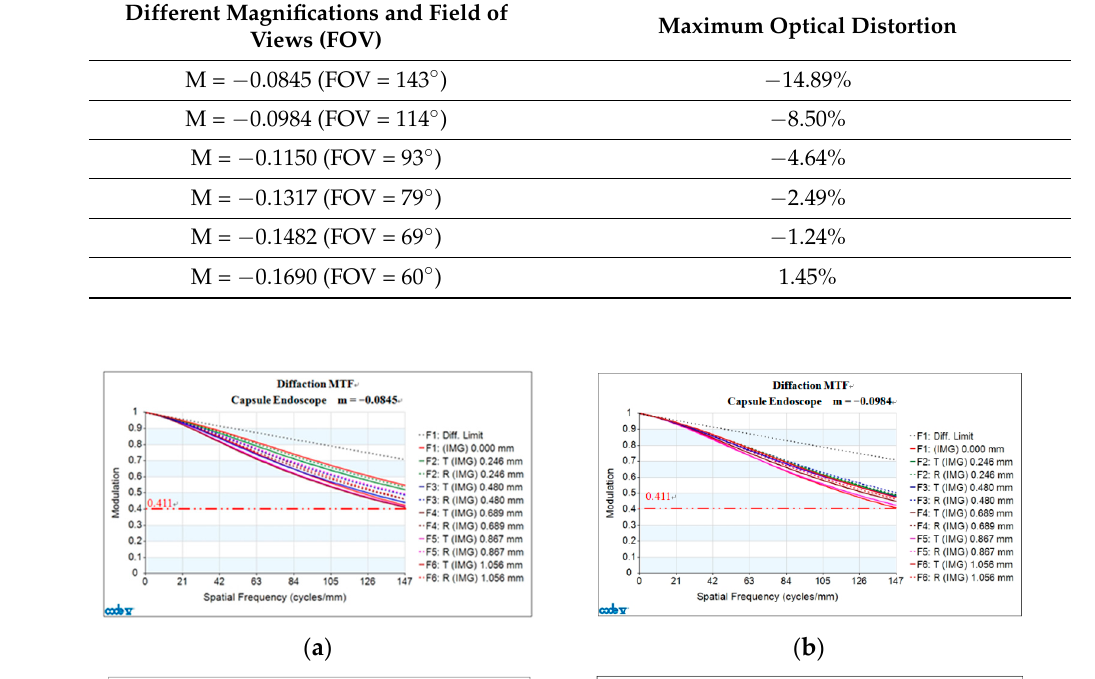
Table 2. Comparison of maximum optical distortion at different magnifications.